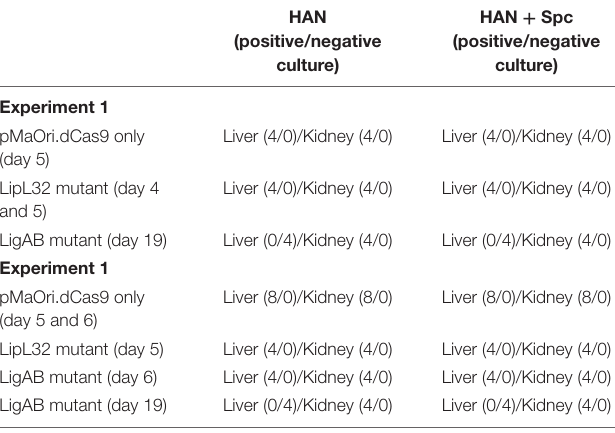
TABLE 2 | Culture results of liver and kidney macerates in HAN media without or with spectinomycin (Spc).